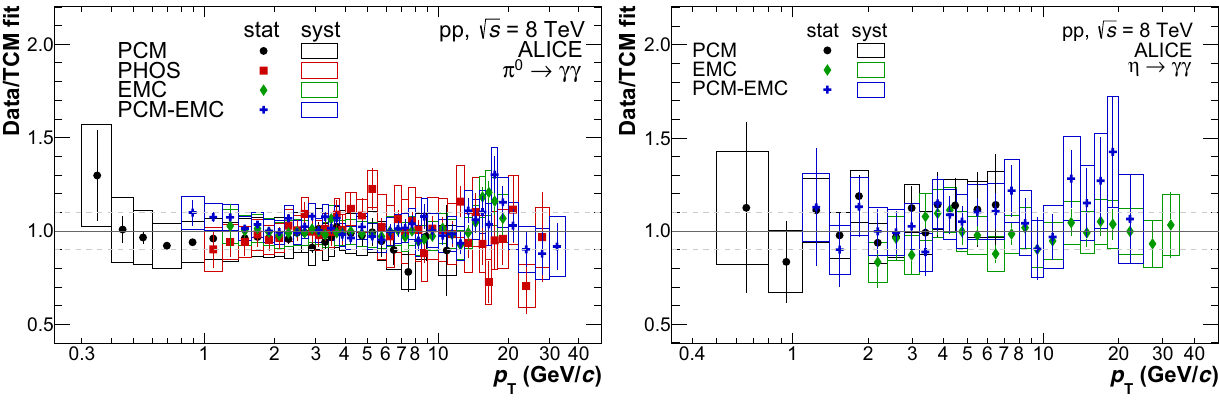
Fig. 6 Ratios of the fully corrected π 0 (left) and η (right) spectra for each reconstruction method to the TCM fit of the combined spectrum